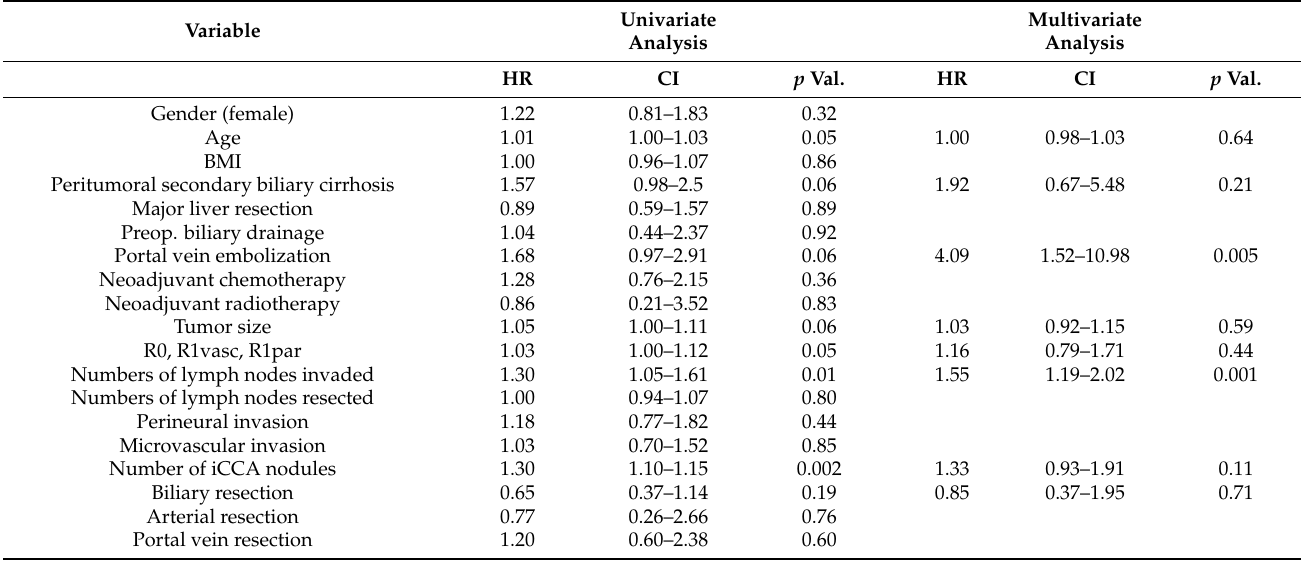
Table 5. Univariate and multivariate analysis for